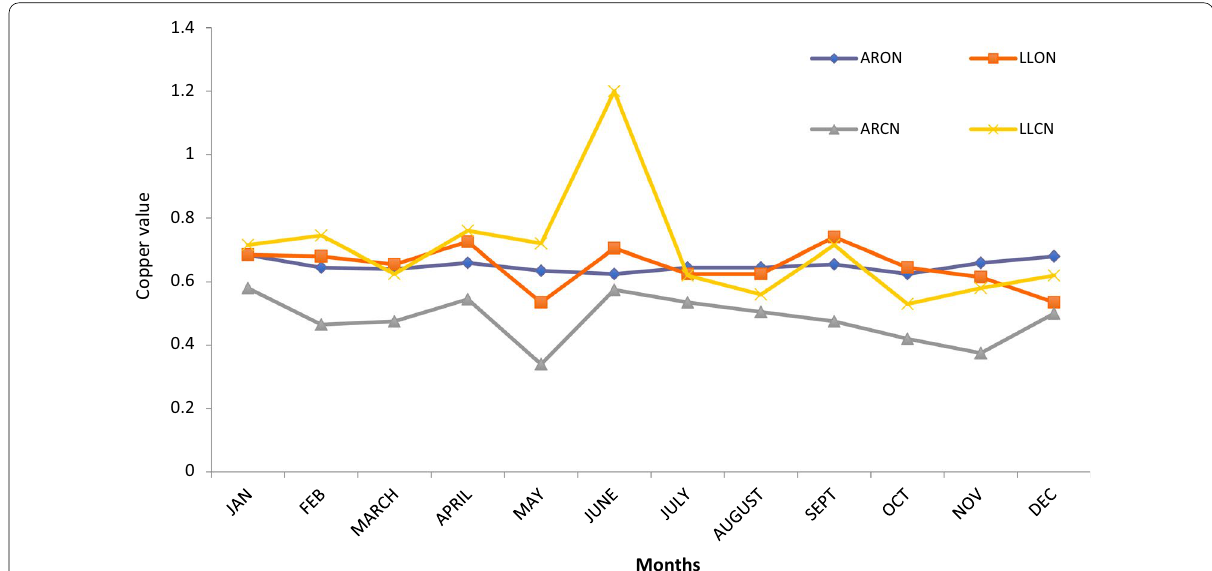
Fig. 6 Mean Comparative Copper (Cu) concentration among C. nigrodigitatus and O. niloticus species collected from Asejire Reservoir and Lagos Lagoon